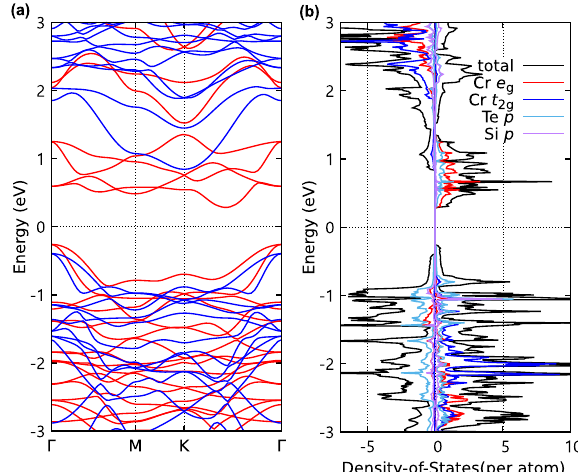
Fig. 2 Band structure and pDOS plot. a Band structure with majority spin (red line) and minority-spin channel (blue line), respectively. b Total density of states (black line), projected density-of-states (pDOS) of Cr e g orbital (red line) and t 2g orbital (blue line), Si p orbital (purple line) and Te p orbital (sky blue line), respectively. In the pDOS plot, plus and minus signs correspond to the majority and minority-spin components, respectively. Fermi level is set to be zero for both